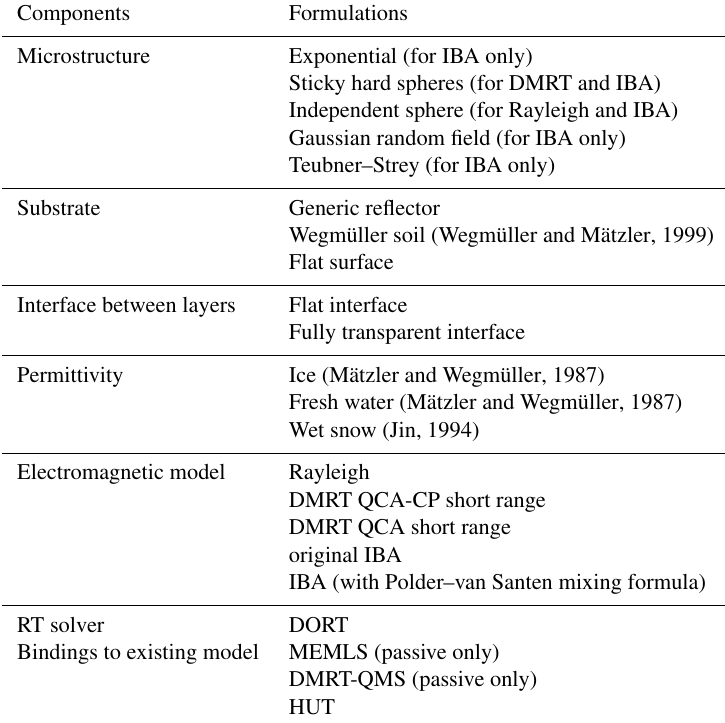
Table 1. SMRT components and different formulations available in version 1.0. Each microstructure can only be used with compatible electromagnetic models as indicated in